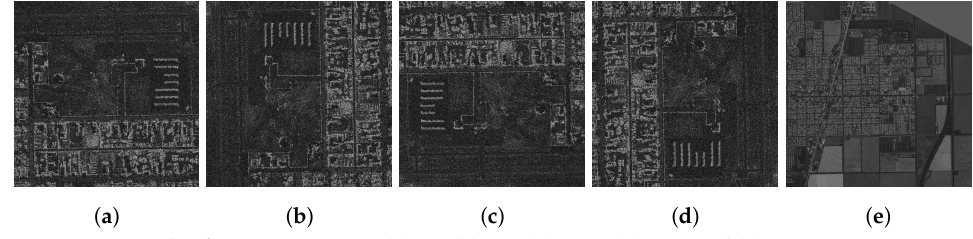
Figure 3. Example of rotation variants ( a ) 0 ◦ , ( b ) 90 ◦ , ( c ) 180 ◦ , ( d ) 270 ◦ and ( e ) zooming out ×